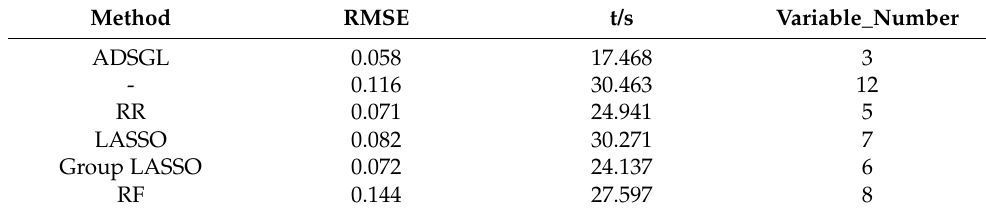
Table 4. Comparison of test results with variable selection methods.